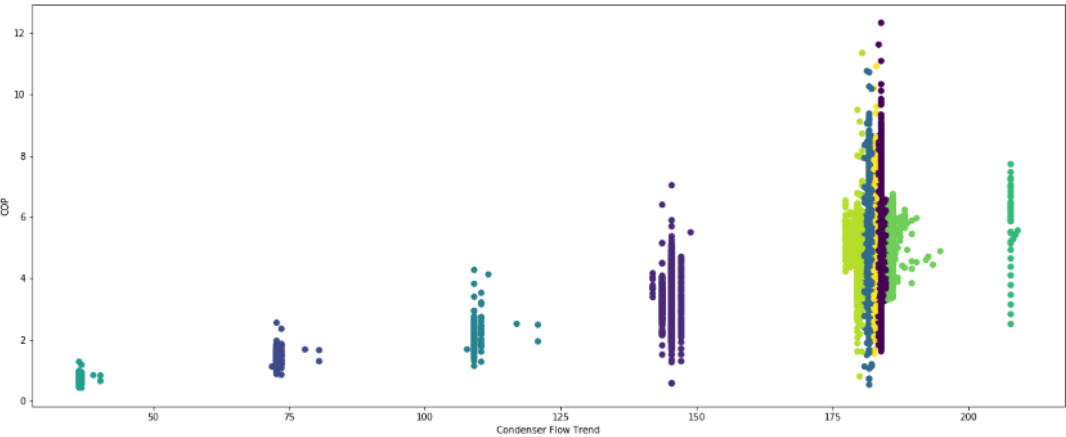
Figure 7. Scatter diagram of the condenser flow trend and COP after clustering.